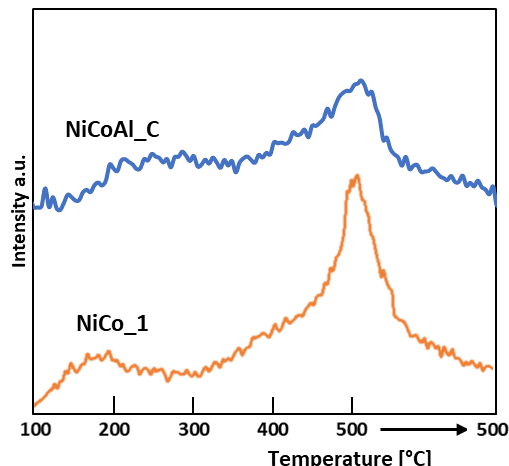
Figure 8. N 2 O-TPD over NiCo_1 and NiCoAl_C catalysts.